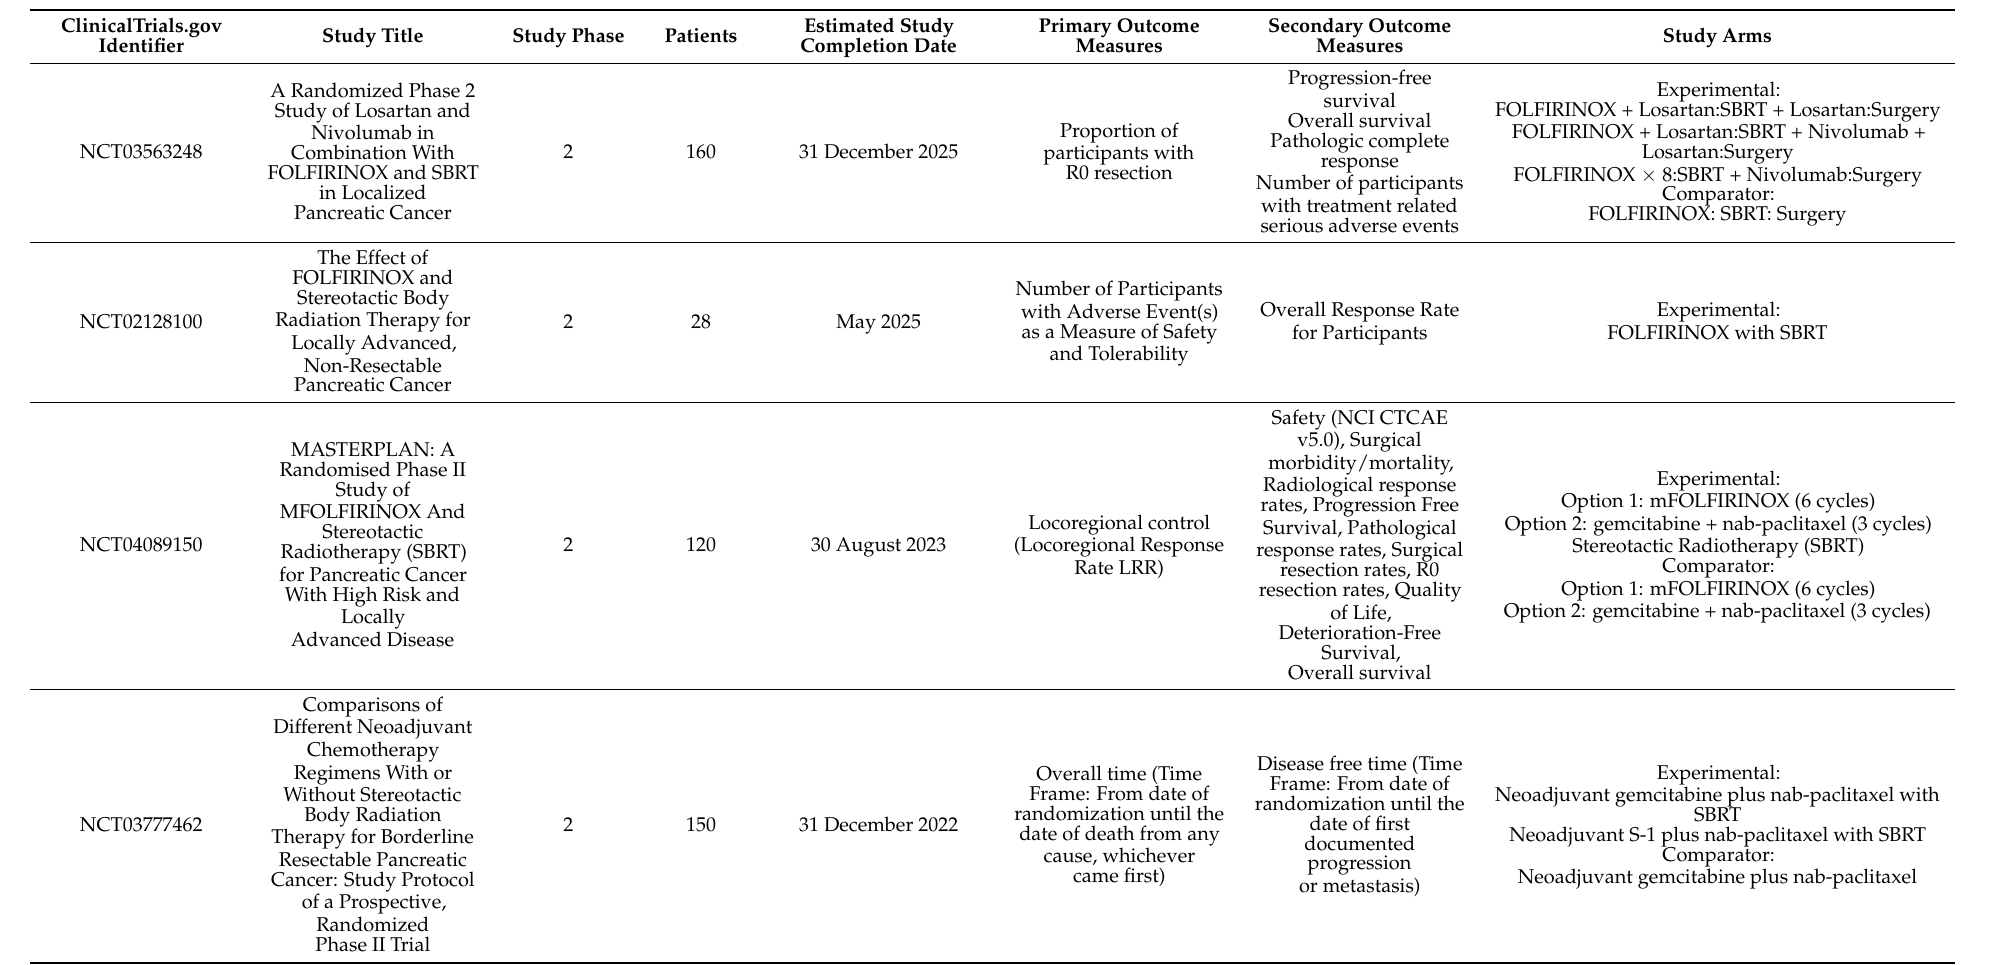
Table 3. Ongoing studies using SBRT in the therapy of pancreatic